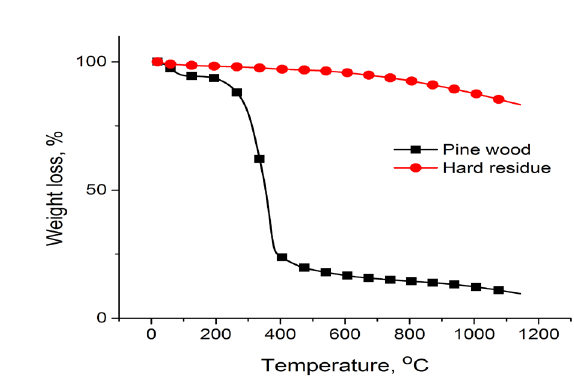
Fig. 6. TG curves of pine wood and its pyrolysed hard residue